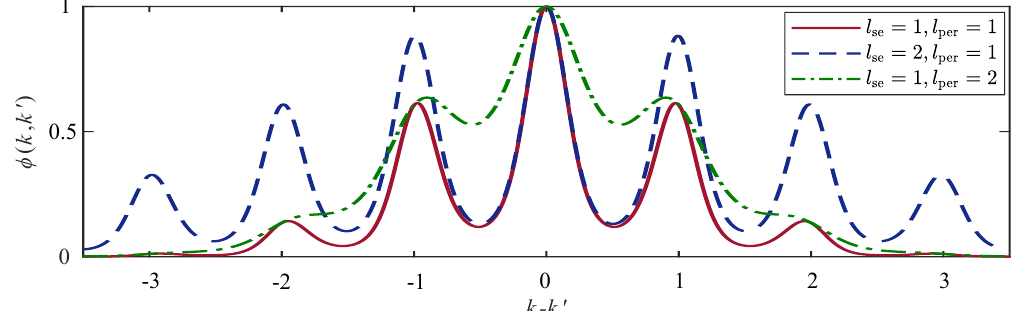
Figure 8. Locally periodic kernels (5) with different length scales l se of the squared-exponential factor and length scales l per of the periodic